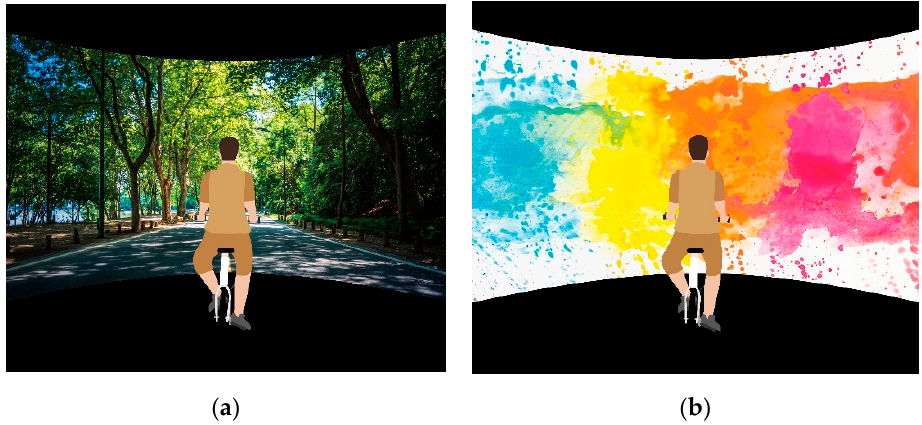
Figure 1. Experimental images. ( a ) virtual nature; ( b ) virtual abstract paintings (Experimental images from evening_tao | Freepik).